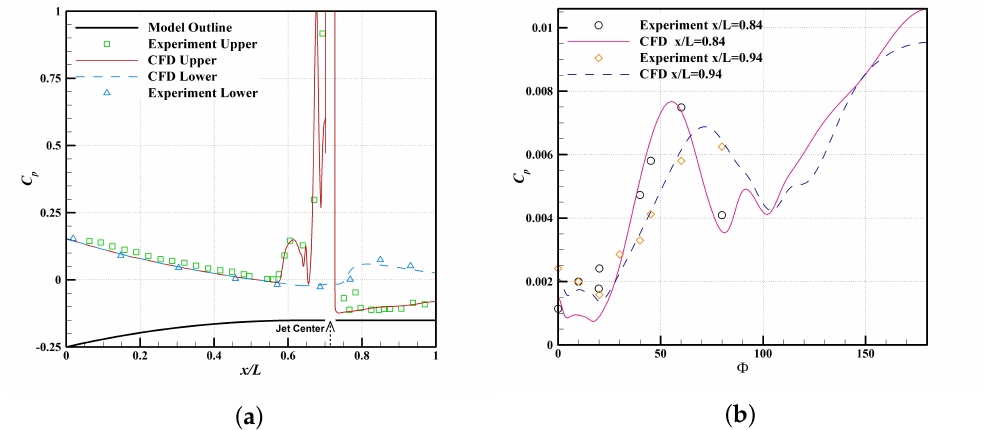
Figure 5. Comparison of Experimental and Computed Longitudinal ( x / L ) and Circumferential ( Φ ) Distribution of Pressure Coefficient C p . ( a ) Upper and Lower Surface. ( b ) Section Plane 0.84 and